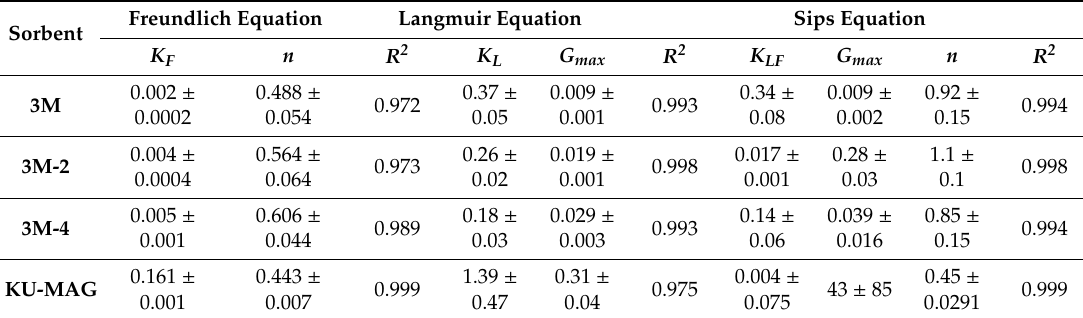
Table 3. Parameters of Freundlich, Langmuir, and Sips equations for the isotherms of Sr 2 + sorption on virgin composite sorbents.